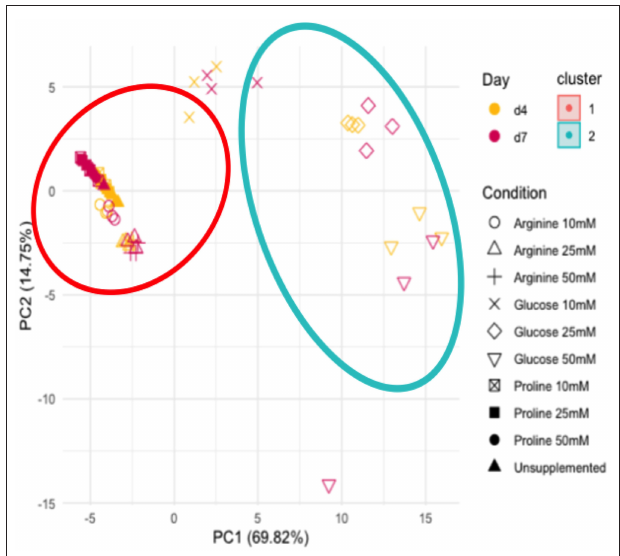
FIGURE 4 | Principle component analysis of all metabolite concentrations, unsupplemented and supplemented biofilms and the sterile saliva. Unsupplemented, unsupplemented